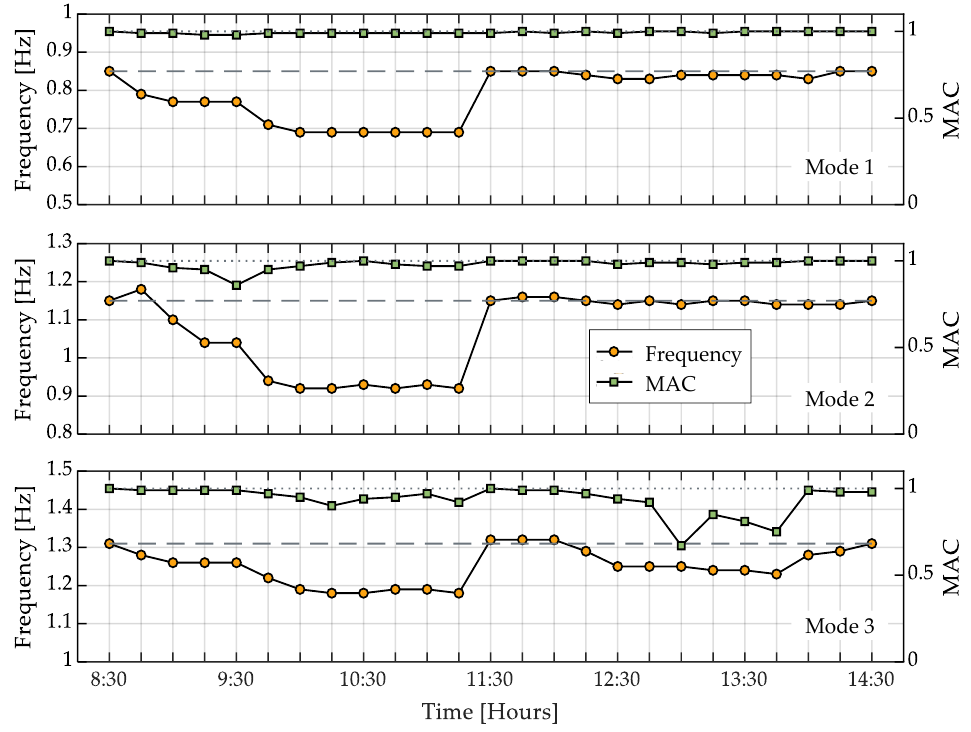
Figure 17. Frequencies and mode shapes of the first three vibration modes during the test day.